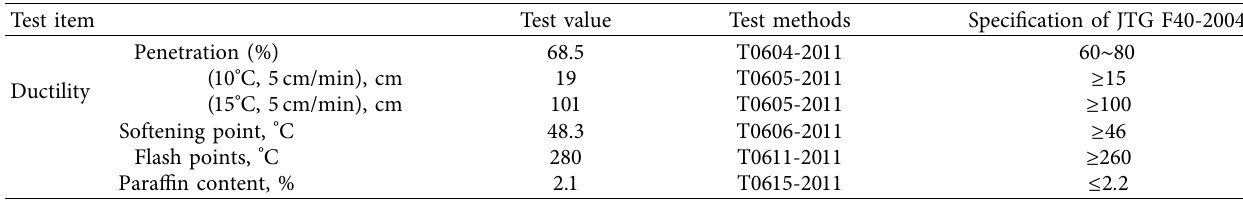
Table 2: Asphalt property test results and standard value.